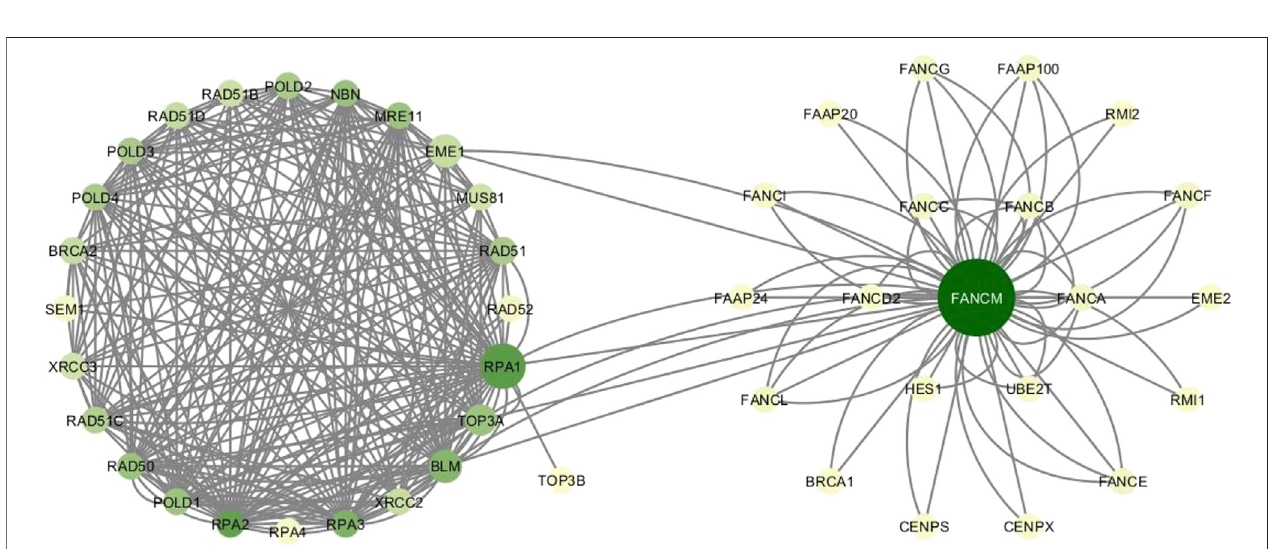
FIGURE 4 | HR network and FANCM network. Colors vary from yellow to green according to increasing degree values. Node sizes grow as the betweenness centrality of nodes.